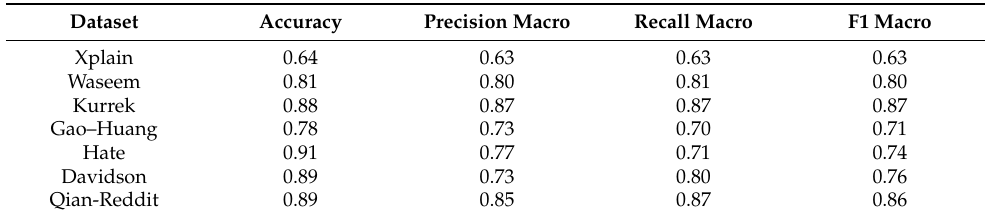
Table A10. Scores obtained on the benchmark Datasets using the learnable parameter encoding model. Embedding vectors were made with both ELMo and GloVe and then concatenated. The auxiliary Dataset is the SemEval 18 [27] Task1 Dataset.